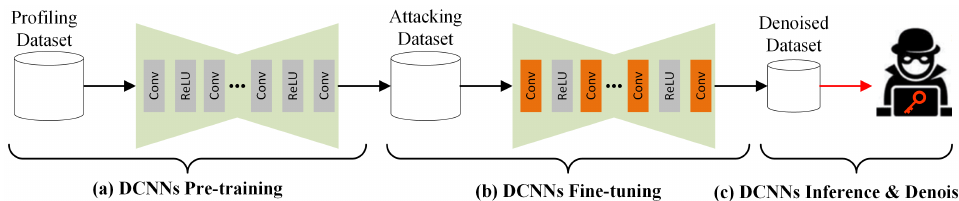
Figure 1. Overview of the proposed denoising framework for profiled SCA attacks: ( a ) Pre-training the DCNNs model (i.e., U-Net) on the paired noisy/clean profiling dataset; ( b ) Fine-tuning the trained DL model on noisy only target dataset; ( c ) Deploying the well-trained DCNNs model on newly collected SCA traces for the noise